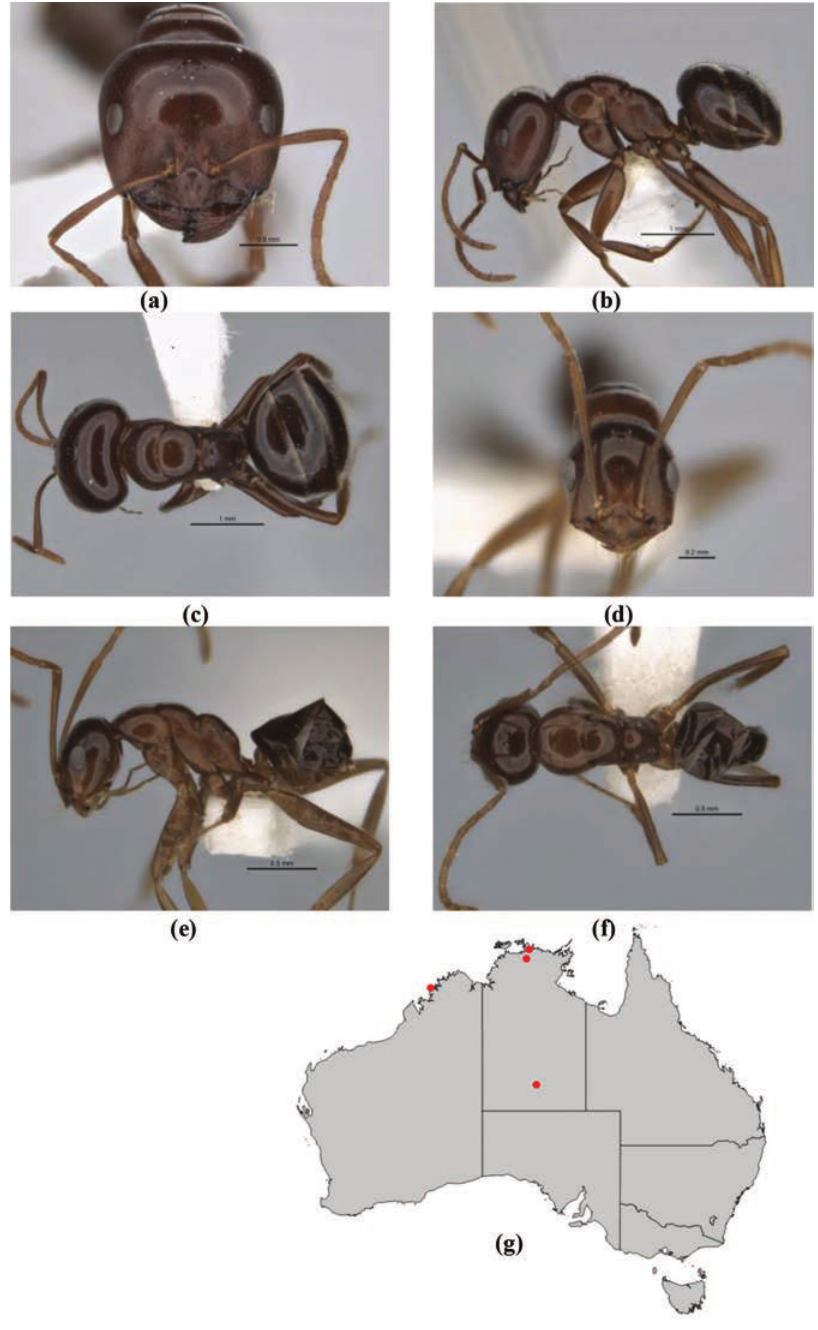
Figure 15. Melophorus kuklos sp. n.: major worker paratype (ANIC32-900094) frons ( a ), profile ( b ) and dorsum ( c ); minor worker holotype (ANIC32-900095) frons ( d ), profile ( e ) and dorsum ( f ); distribution map for the species ( g ). Low resolution scale bars: 1 mm ( b, c ); 0.5 mm ( a, e–f ); 0.2 ( d